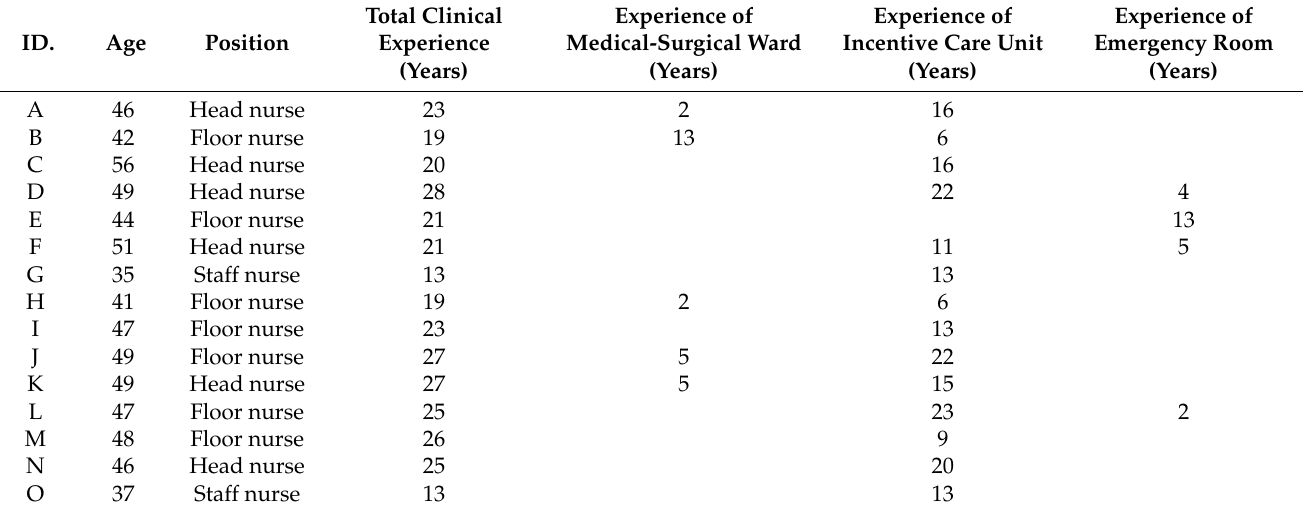
Table 3. Demographic characteristics of participants (N =